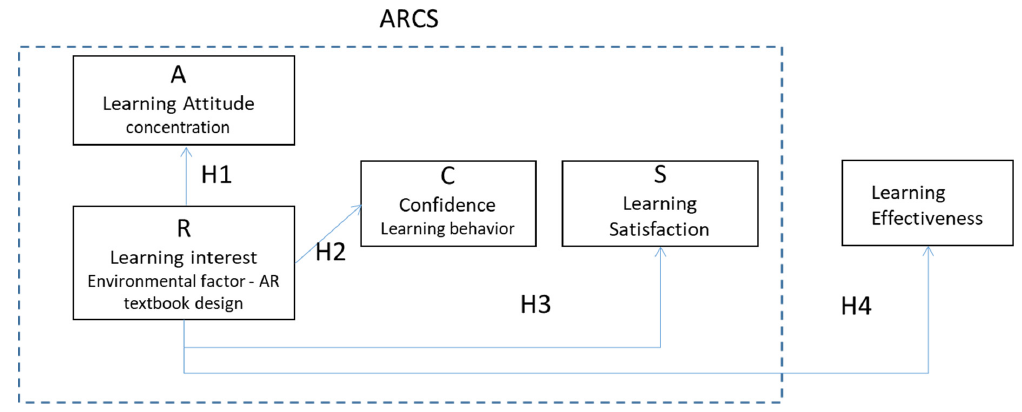
Figure 7. The ARCS learning effectiveness statistical model and the research hypotheses.